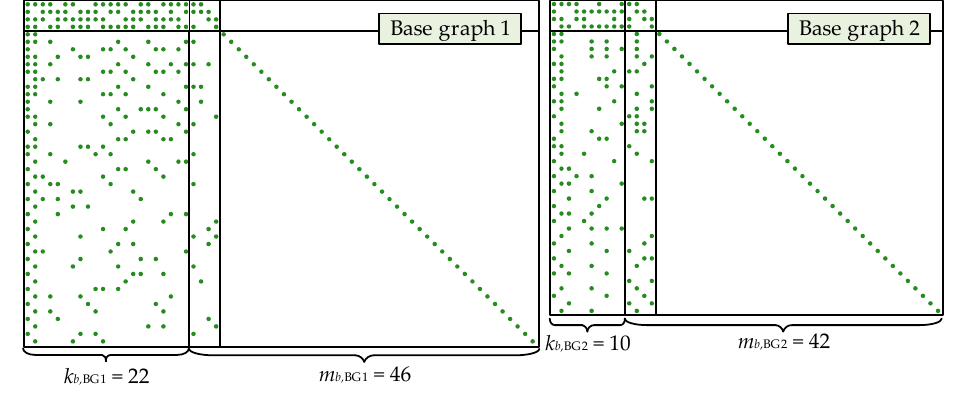
Figure 1. Base graph matrix structures for codes in 5G NR.